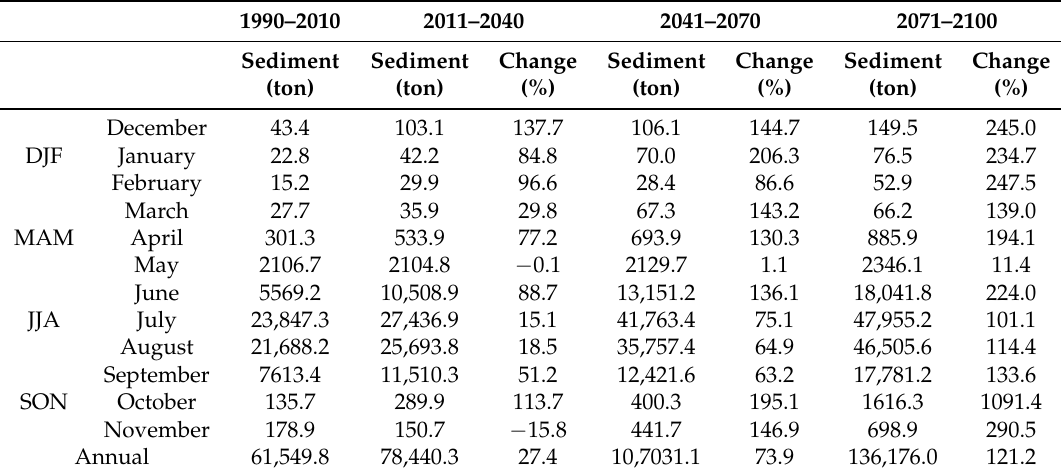
Table 8. Monthly projection of sediment by periods at Hapcheon Dam